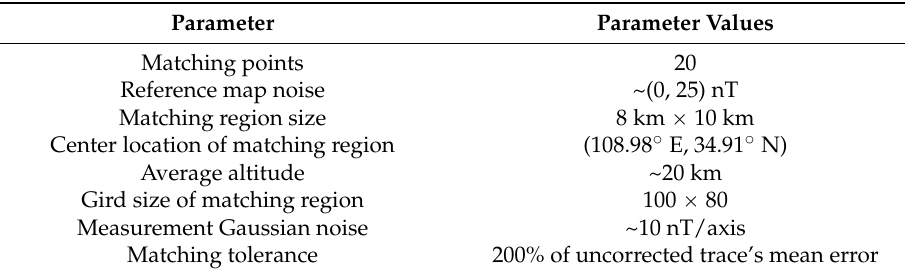
Table 1. The parameters of